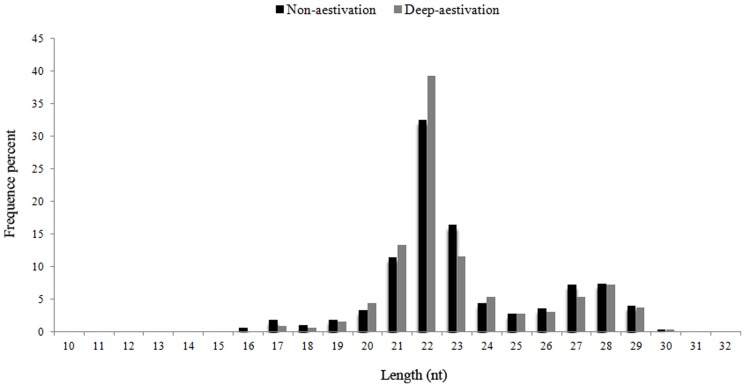
Length distributions of clean reads in NA and DA.The x-axis indicates sequence sizes from 10 nt to 32 nt. The y-axis indicates the percentage of reads for every given size.